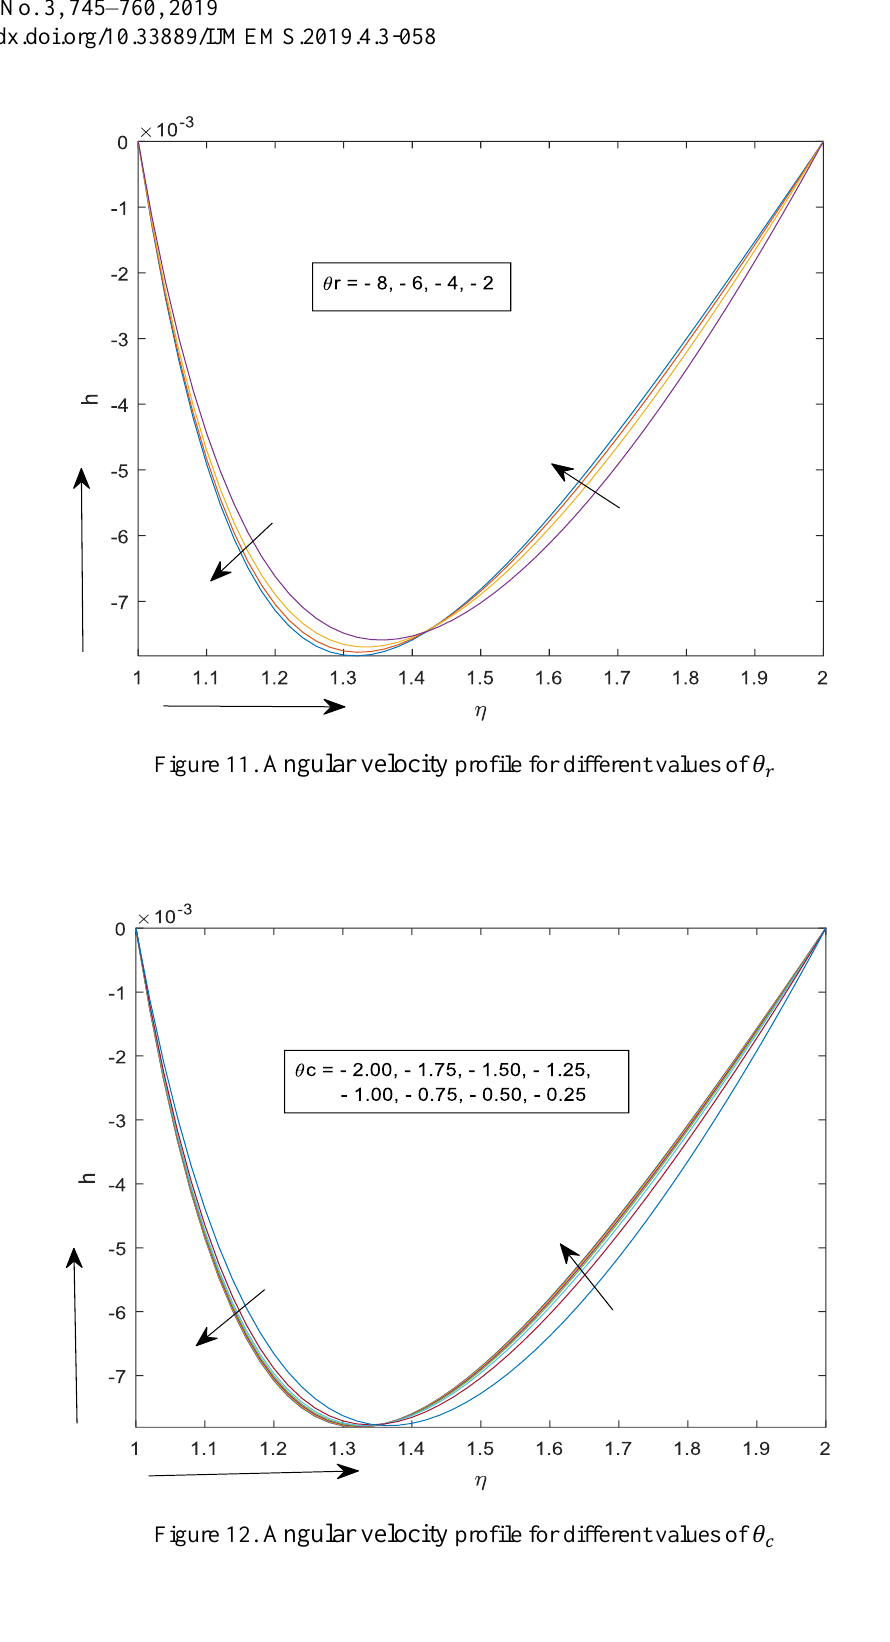
Figure 12. Angular velocity profile for different values of 𝜃